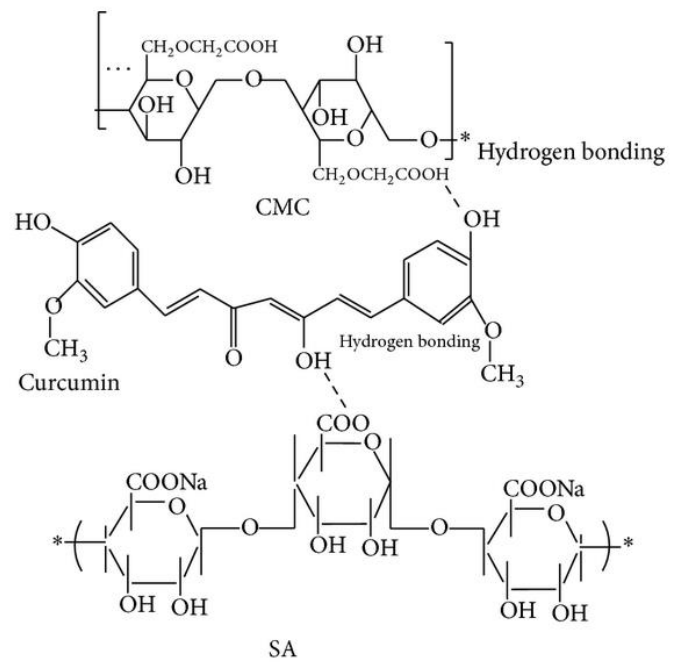
Figure 4. The structure of curcumin–alginate–CMC beads [57]. Turmeric extract concentration influences spherical, egg, and rectangular shape forma- tion. Higher release rates were demonstrated in the case of higher extract